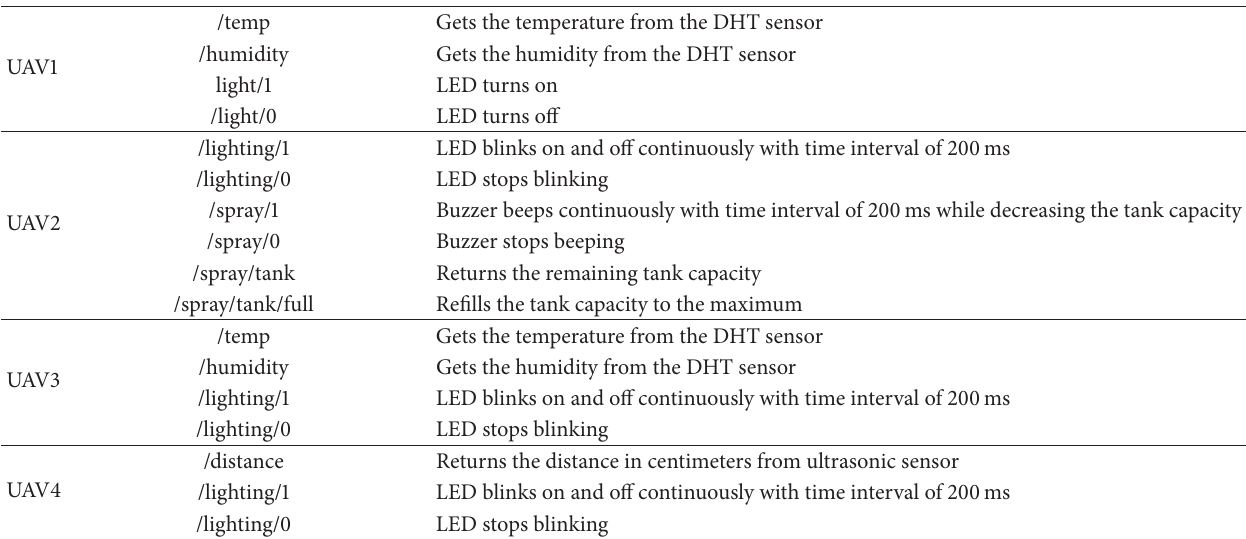
Table 2: Implemented UAVs resources and their interfaces.